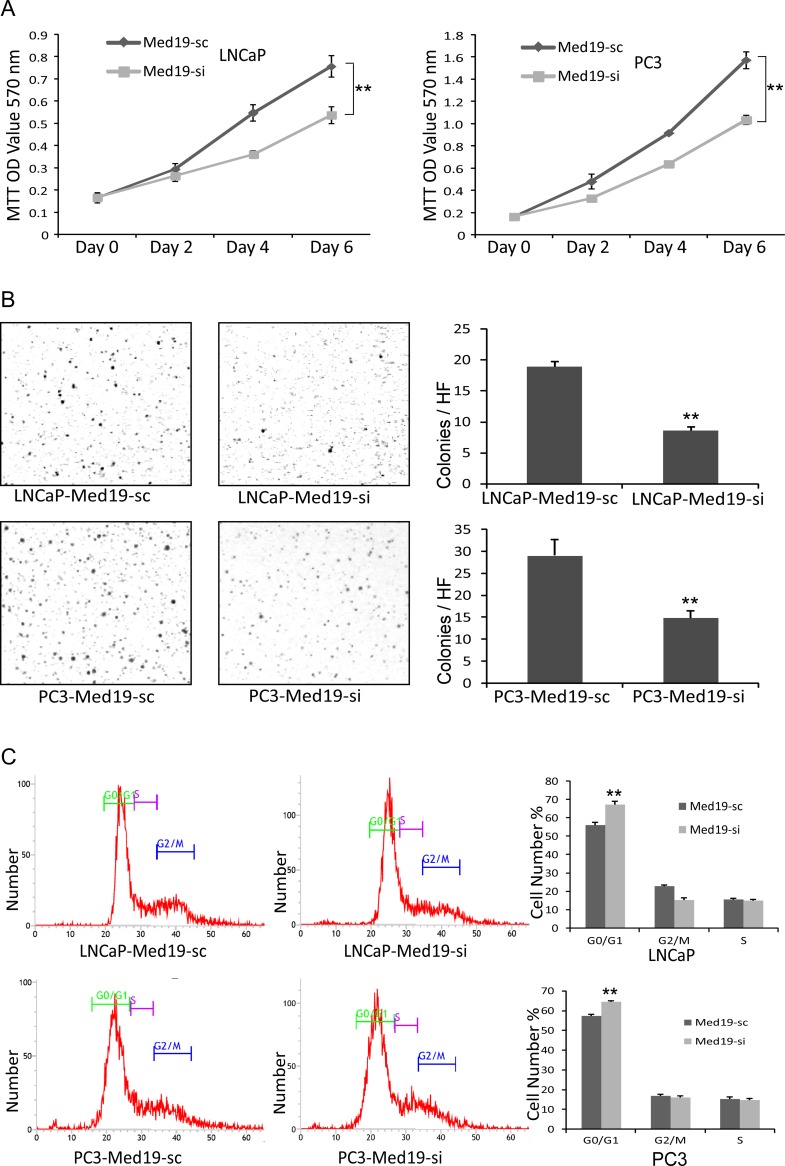
Knockdown of Med19 inhibited cell growth via arresting cell cycle.(A) In MTT assay, the growth curves showed the LNCaP-Med19-si and PC3-Med19-si cells grew much slower than the control cells. (n = 3, **P<0.01). (B) In colony formation assay (soft agar assay), the LNCaP-Med19-si cells formed 8.61±0.51 colonies/HF, and the LNCaP-Med19-sc cells formed 18.89±0.82 colonies/HF. (n = 3, **P<0.01). The PC3-Med19-si cells formed 14.89±1.51 colonies/HF, and the PC3-Med19-sc cells formed 29.06±3.62 colonies/HF. (n = 3, **P<0.01). (C) In flow cytometry cell cycle analysis, the proportion of G0/G1 phase cells was significantly increased in LNCaP-Med19-si and PC3-Med19-si cells. The proportion of G0/G1 was 67.29±1.70% in LNCaP-Med19-si cells and 56.23±1.46% in LNCaP-Med19-sc cells (n = 3, **P<0.01). The proportion of G0/G1 was 64.39±0.62% in PC3-Med19-si cells and 57.29±0.97% in PC3-Med19-sc cells (n = 3, **P<0.01).